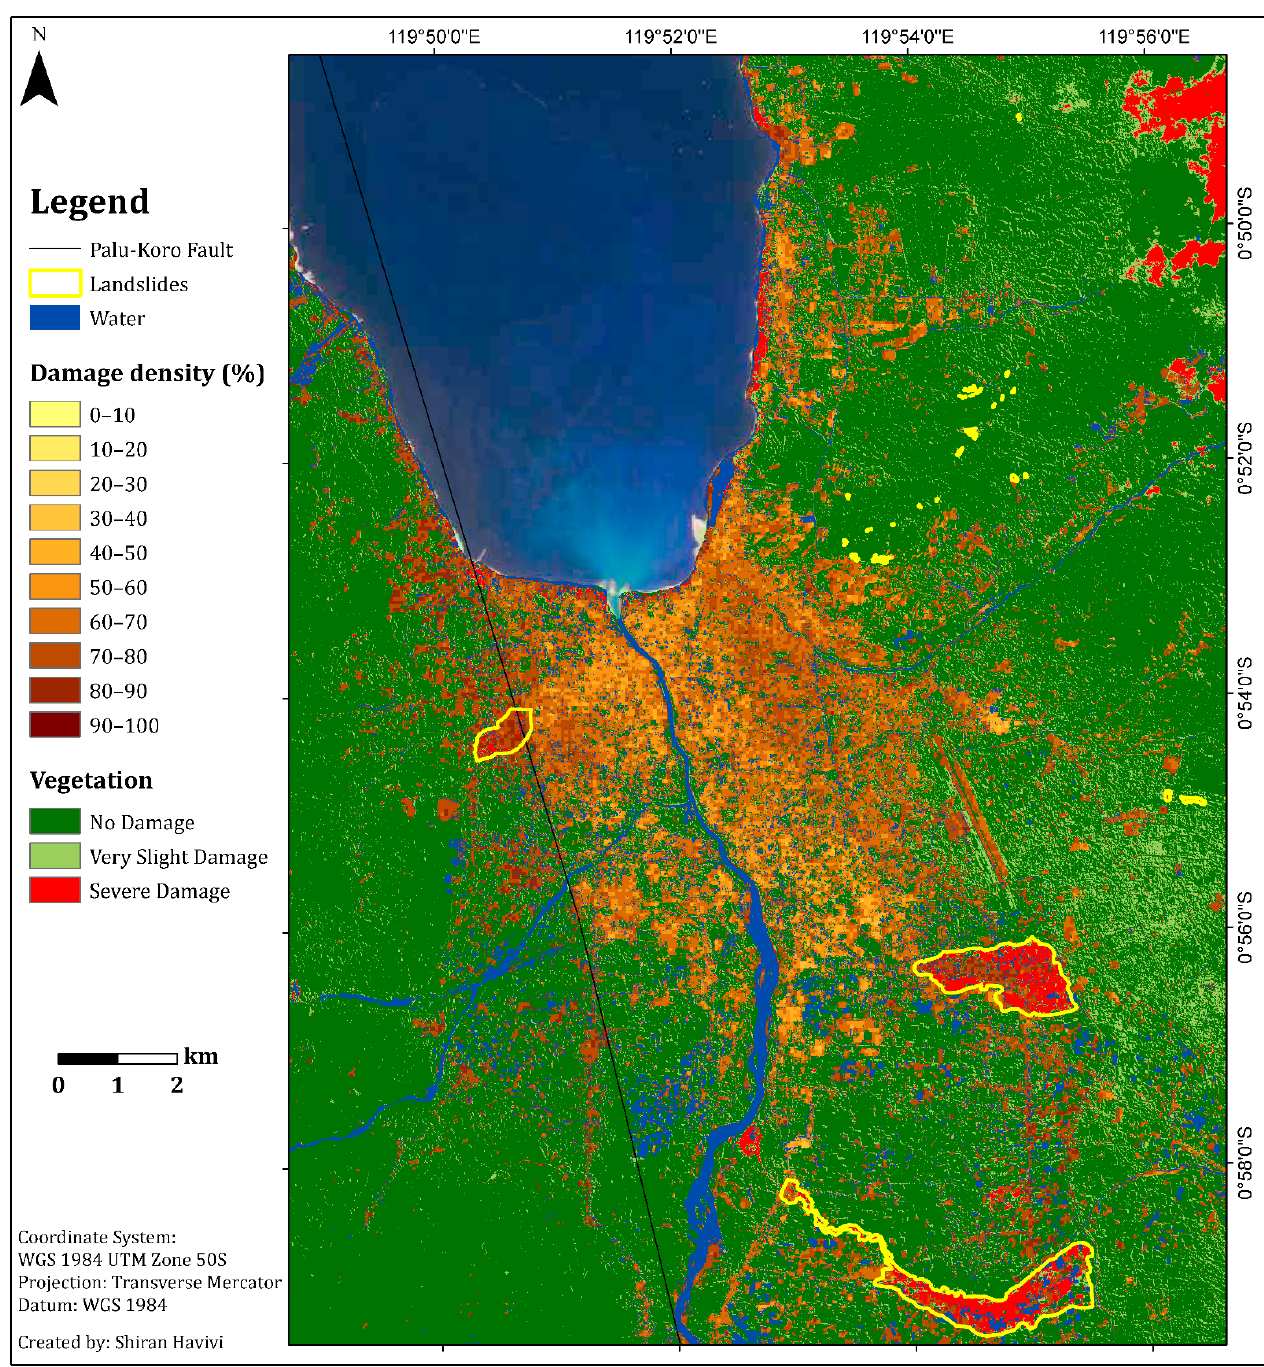
Figure 13. Final damage assessment map (50 m per pixel) generated using both damage assessment methods for the built-up and vegetation areas. Light colors represent a lower probability of damage, dark colors represent a higher probability of damage. Blue represents water bodies. The black line represents the Palu-Koro Fault. Flow slide areas are outlined in yellow. Dark green represents undamaged vegetation. Light green represents a slight change in vegetation. Red represents severe damage to vegetation.